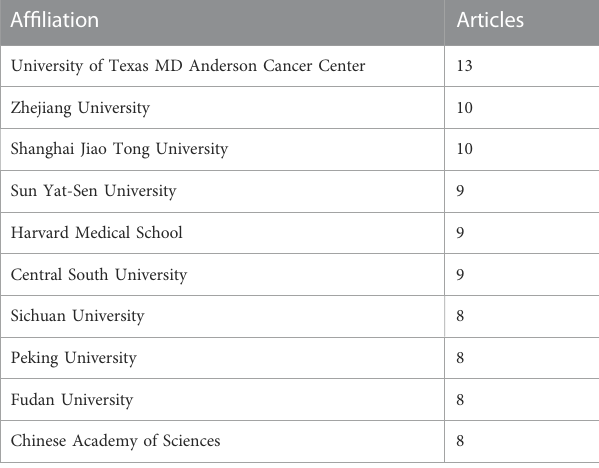
TABLE 3 Top 10 institutions with the largest number of publications. Af fi liation